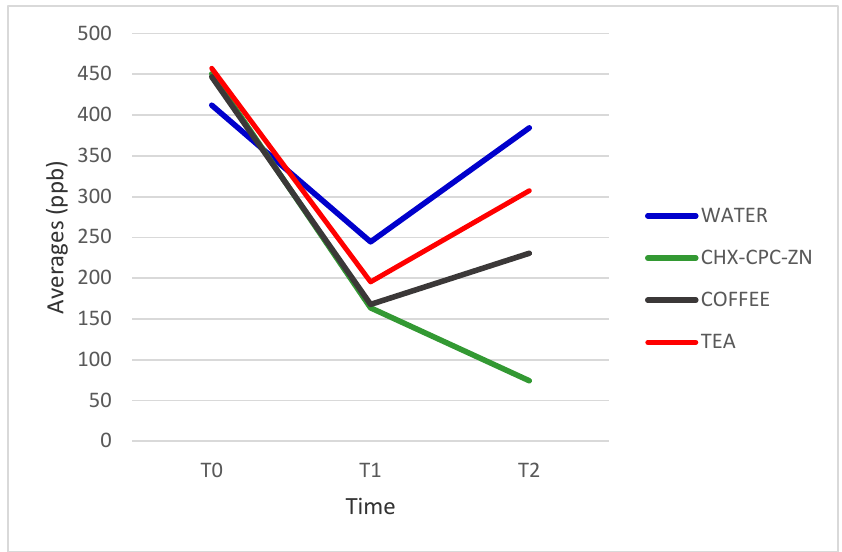
Figure 2. Variation in averages of H 2 S for all interventions at three time intervals.